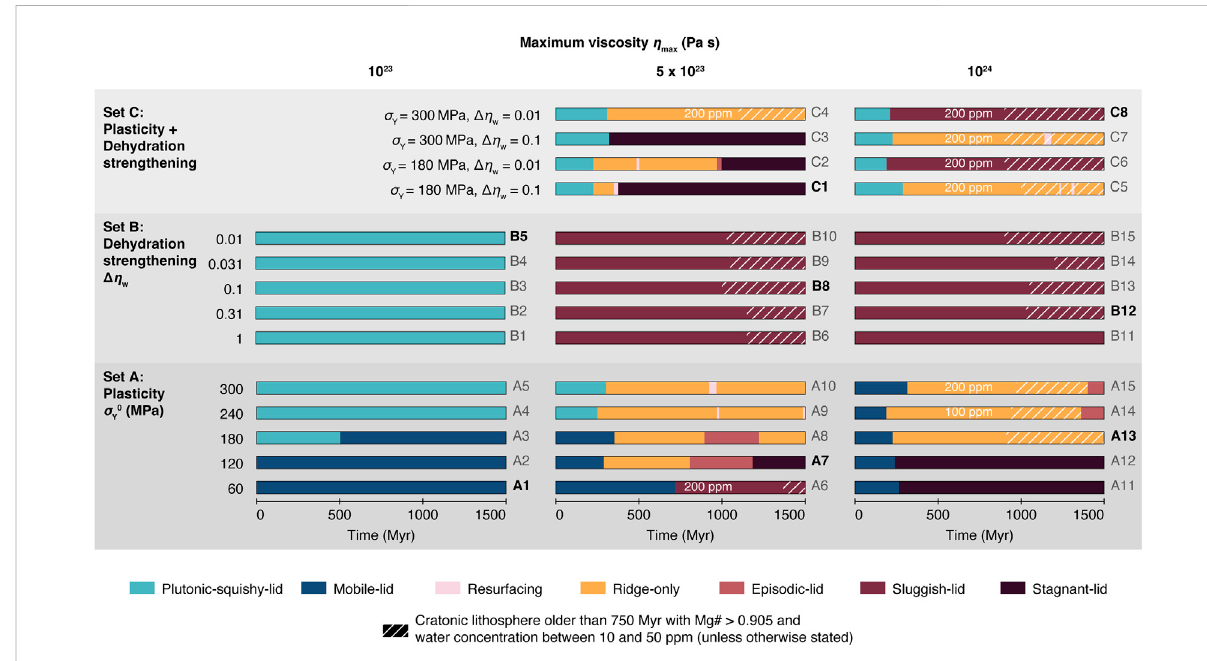
FIGURE 4 Temporal evolution of different tectonic regimes for the entire parameter space. Also highlighted are the cases with cratonic roots and regional-scale resurfacing events. A selection of cases (with bold names) are further explored in Figures 5,